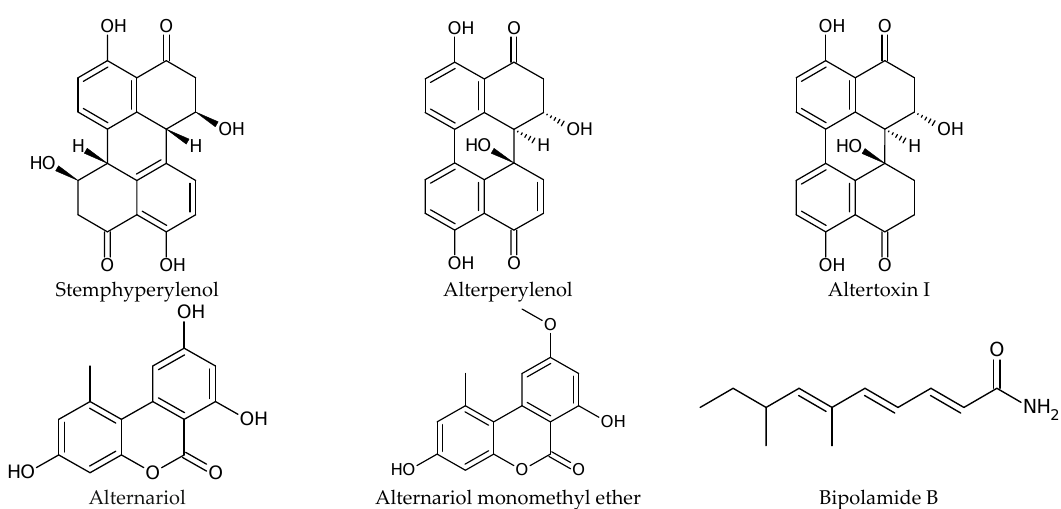
Figure 4. The molecular structure of chosen specific compounds with antifungal activity synthesized by fungal endophytes associated with Asteraceae species [85,100].